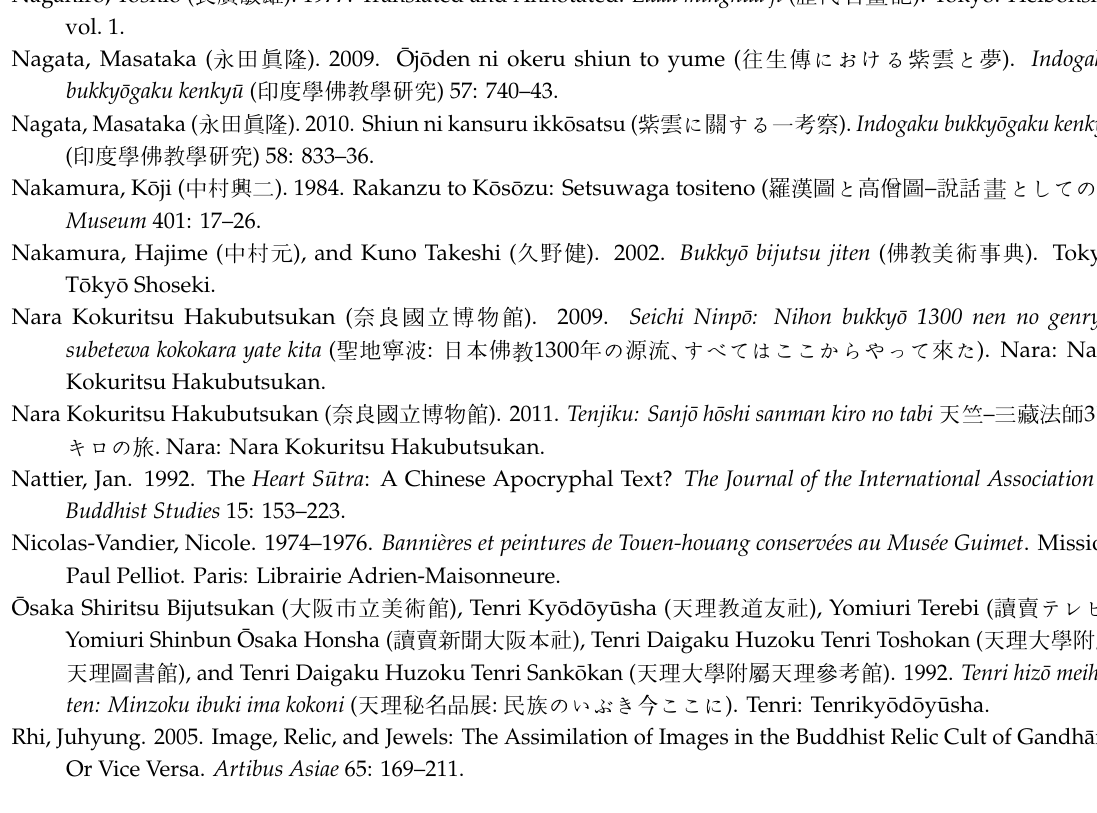
Figure 7. Itinerant Monk . Dunhuang, 10th century. Ink and colors on paper, 51.8 × 29. 3 cm. Inv. No. Dh-320. The State Hermitage Museum, St. Petersburg. Photograph © The State Hermitage Museum, Photo by Leonard Kheifets.